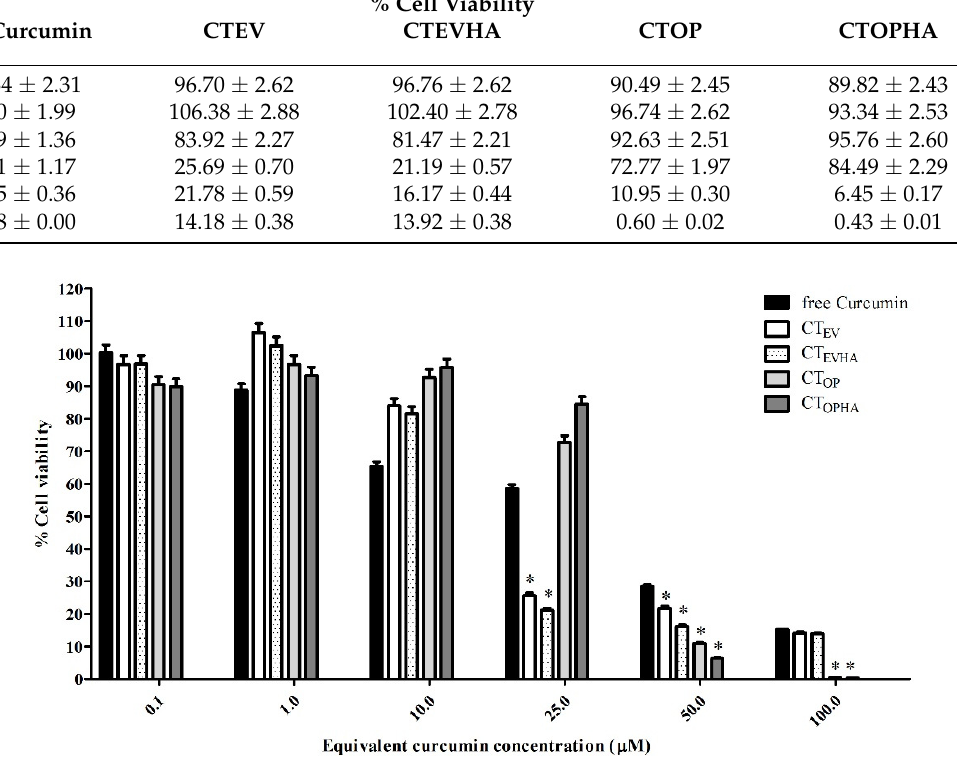
Figure 5. Cytotoxicity of turmeric rhizome extract nanoparticles quantified by MTT assay. The data are expressed as the percentage relative to the vehicle (control) and are shown as mean ± SD ( n = 3). CT EVHA and CT EV = TE-NPs prepared from ethanol extract (EV) with and without sodium hyaluronate (NaHA), respectively. CT OPHA and CT OP = TE-NPs prepared from optimal formulation with and without sodium hyaluronate (NaHA), respectively. *, p < 0.05 versus free curcumin.